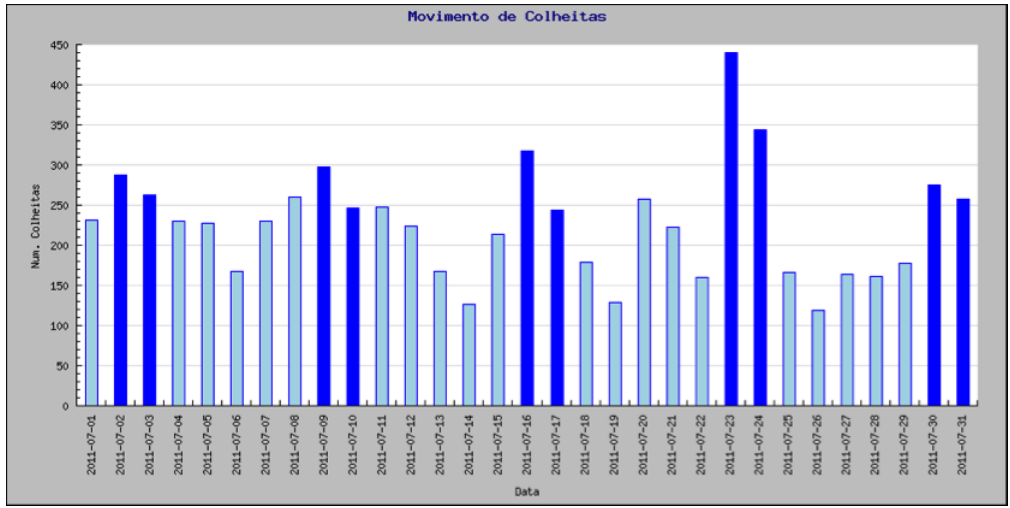
Figure 4: The collections of July 2011 grouped by day. The blue bars represent collections on Saturdays and Sundays and cyan bars represent collections in